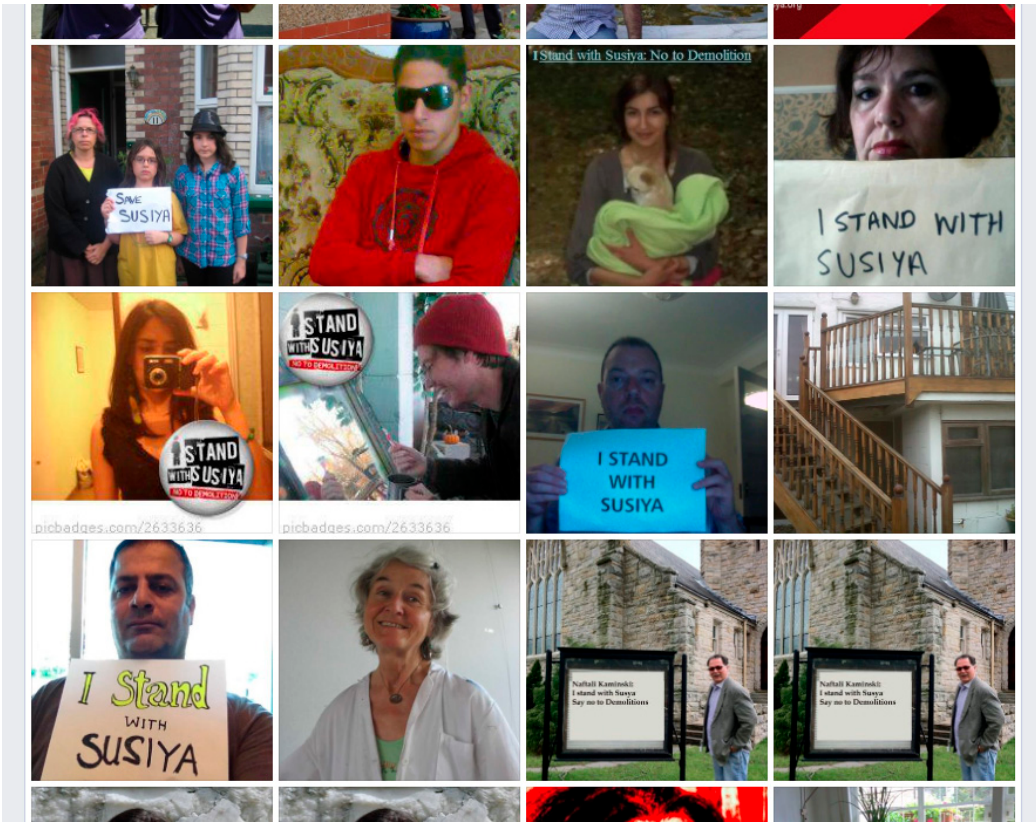
Figure 8. Screen grab of the Stand with Susiya—No to Demolition Facebook image gallery of campaigners visualising their solidarity (Accessed on 7 June 2016).